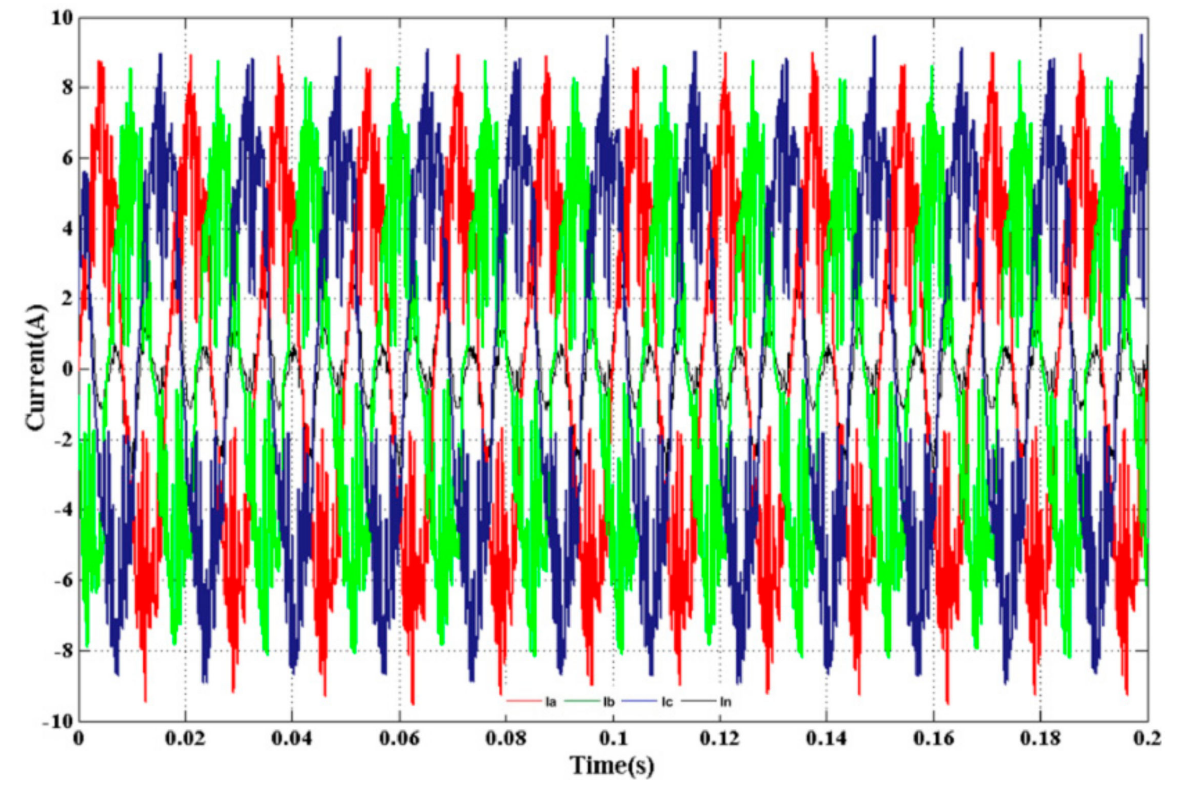
Figure 16. Source current before SAPF compensation for case